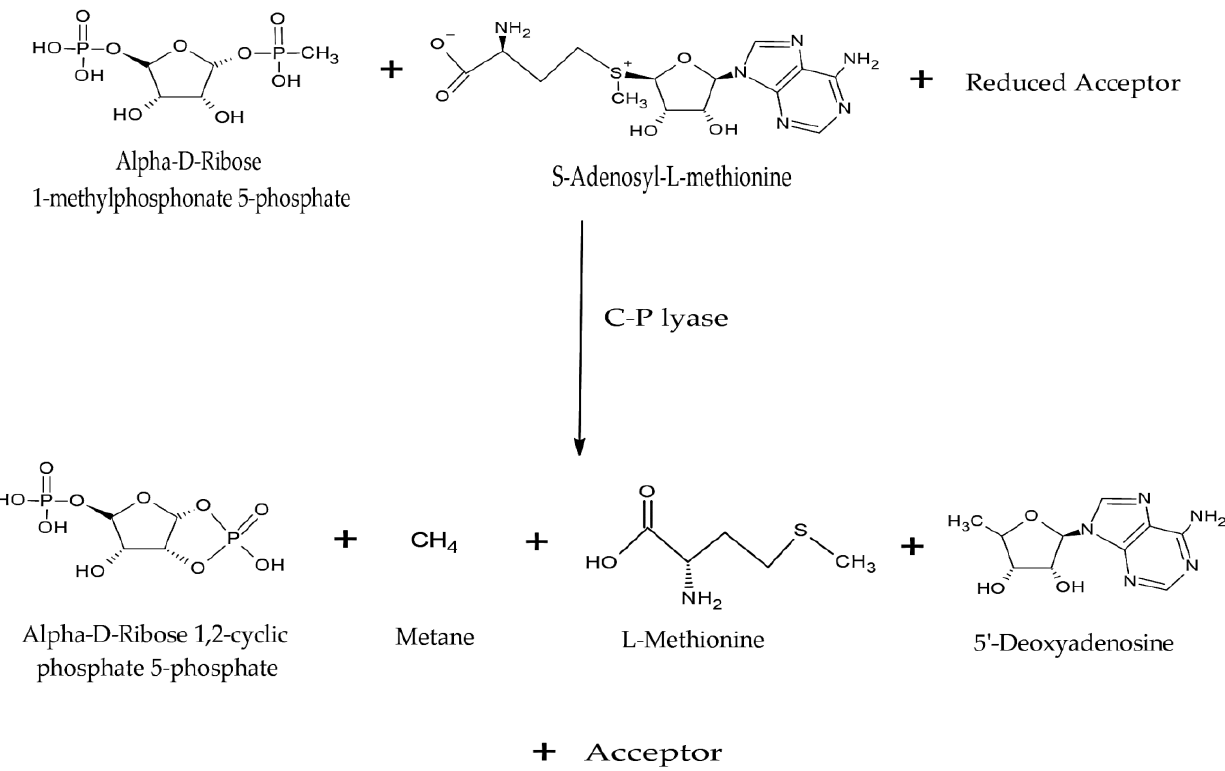
Figure 6. The catalytic reaction of α -D-ribose-1-methyl phosphonate-5-phosphate C–P lyase (me- thane-forming).